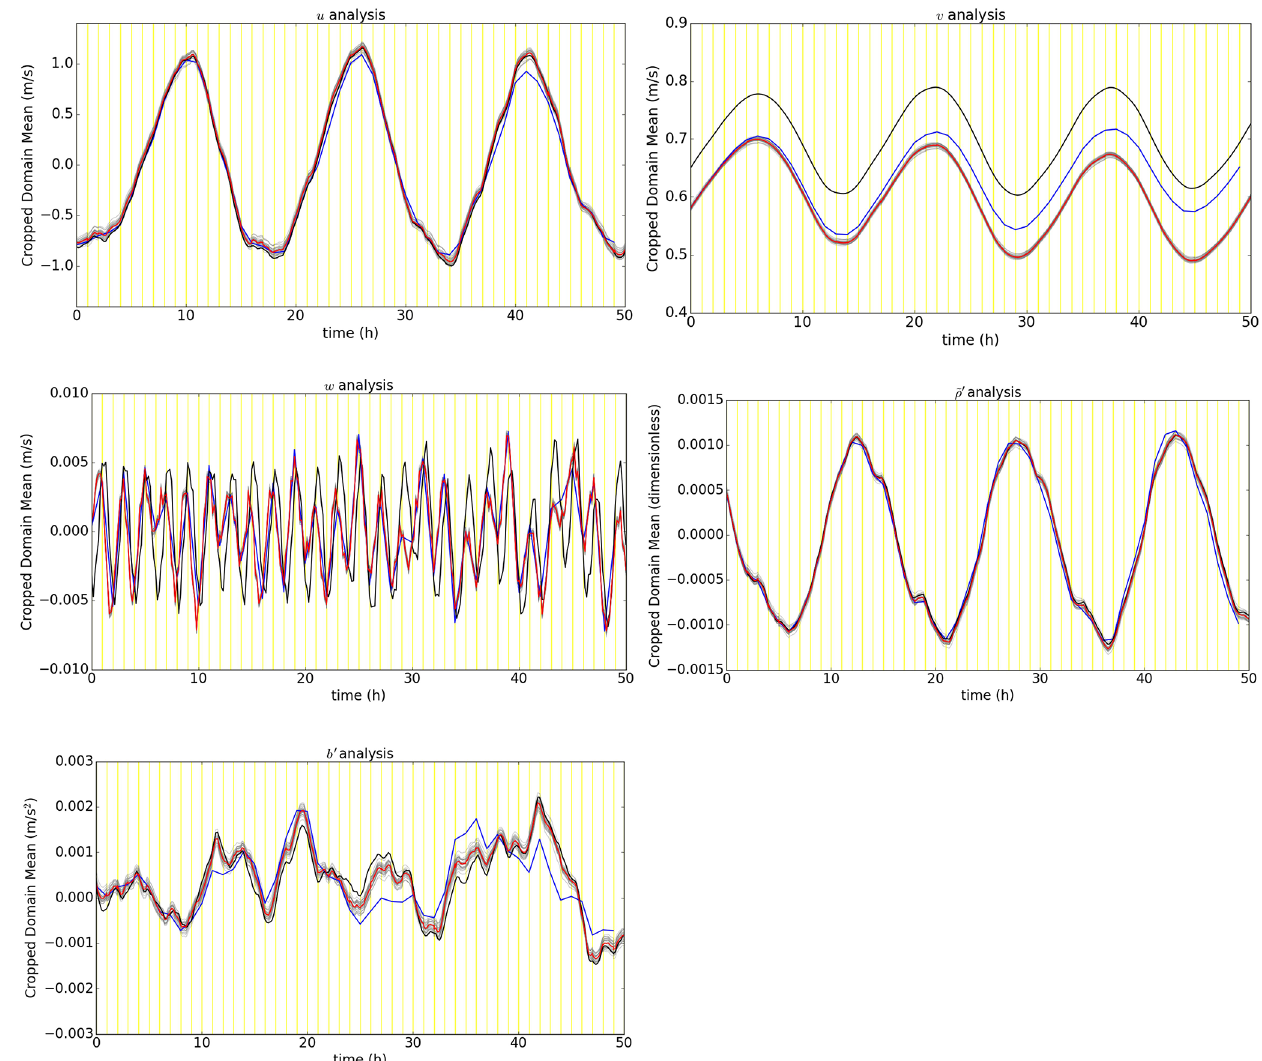
Figure 6. EBV(d) (100% B e ) ensemble trajectories derived from grid point-averaged analysis fields and their forecasts over a subset of the full domain (a box located at the centre of the domain, model levels 25 to 35, longitudinal grid points 127 to 237). The corresponding ensemble mean (red), free background (blue), and “truth” (black) trajectories for the same subset domain are plotted alongside the individual ensemble member (grey) trajectories. Values for the free background are indicated every hour and every 10m for the other